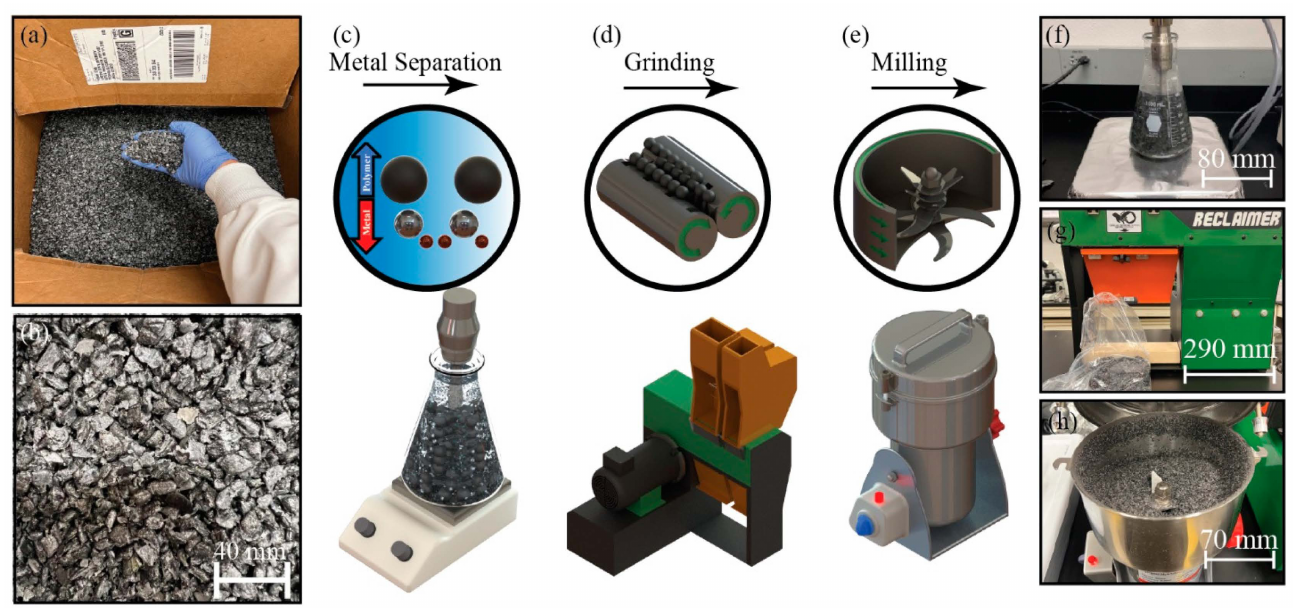
Figure 1. ( a ) XLPE pellets, ( b ) zoom-in with 40 mm scale bar of the XLPE solid waste